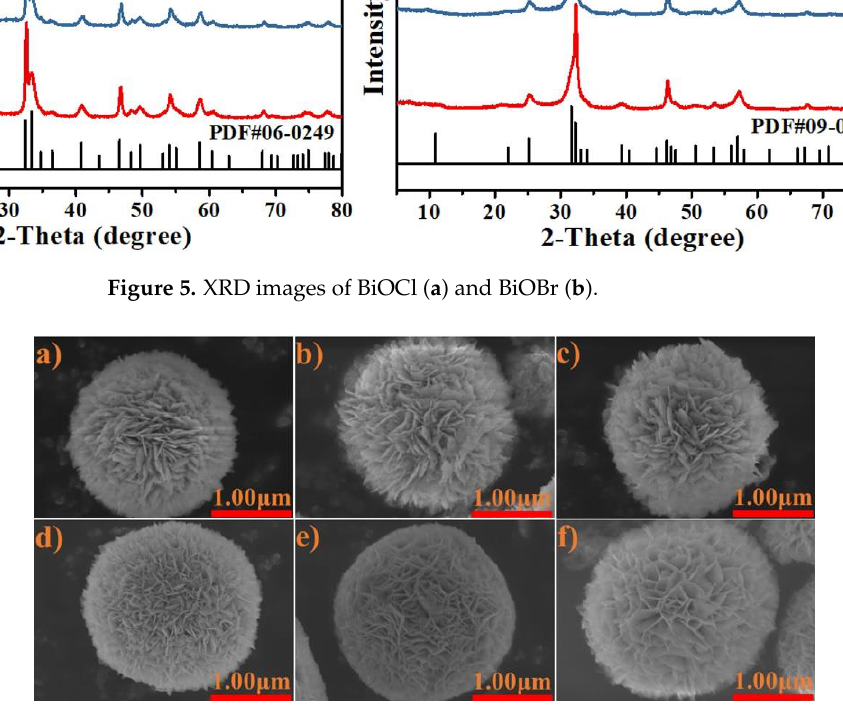
Figure 5. XRD images of BiOCl ( a ) and BiOBr ( b ).